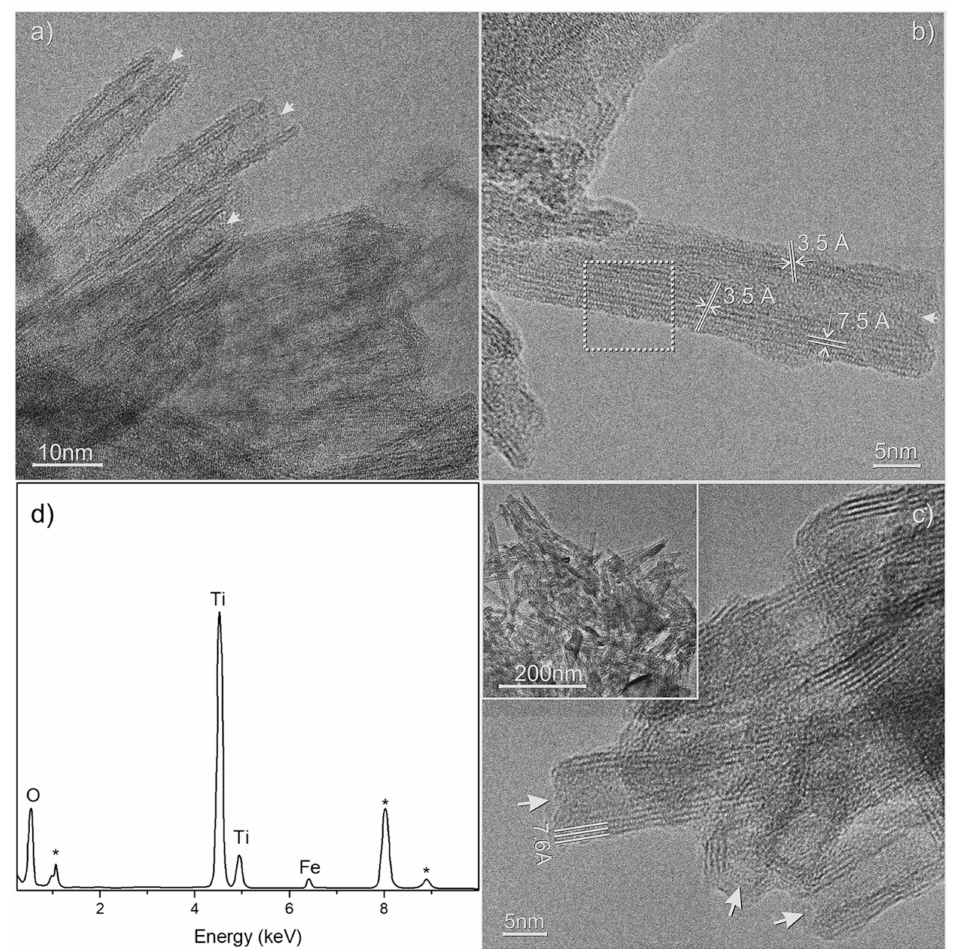
Figure 3. HRTEM images of: ( a , b ) hydrogen titanate nanotubes; ( c ) the same nanotubes after ion exchange with Fe(NO 3 ) 3 (0.0025 M), and ( d ) the related EDAX spectrum. Cavities of the nanotubes are evidenced by the arrows in a – c